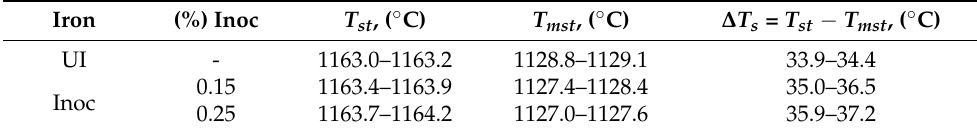
Table 2. Calculated stable ( T st ) and metastable ( T mst ) eutectic temperatures.